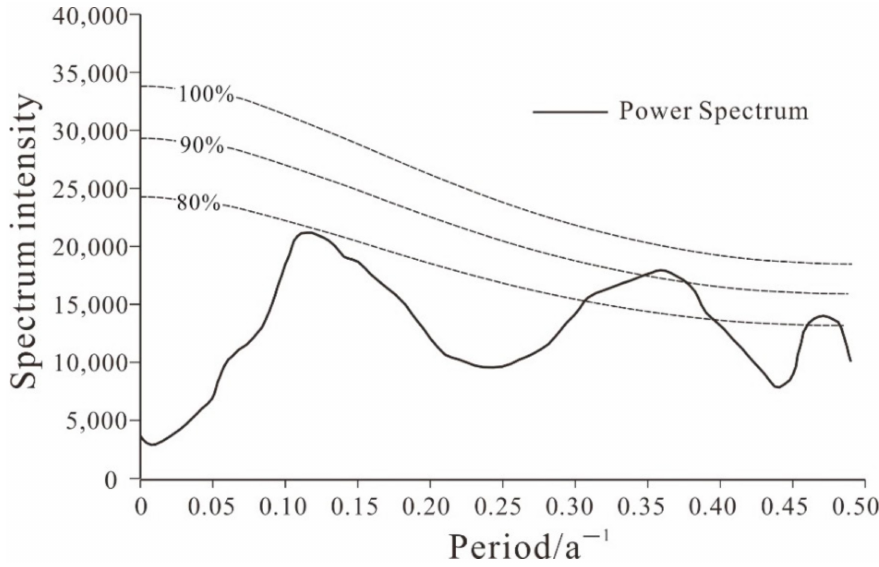
Figure 3. Analysis of the annual rainfall cycle in the YRB from 1961 to 2010. Table 1. Climate inclination rate with respect to rainfall in different seasons in the YRB (mm/10